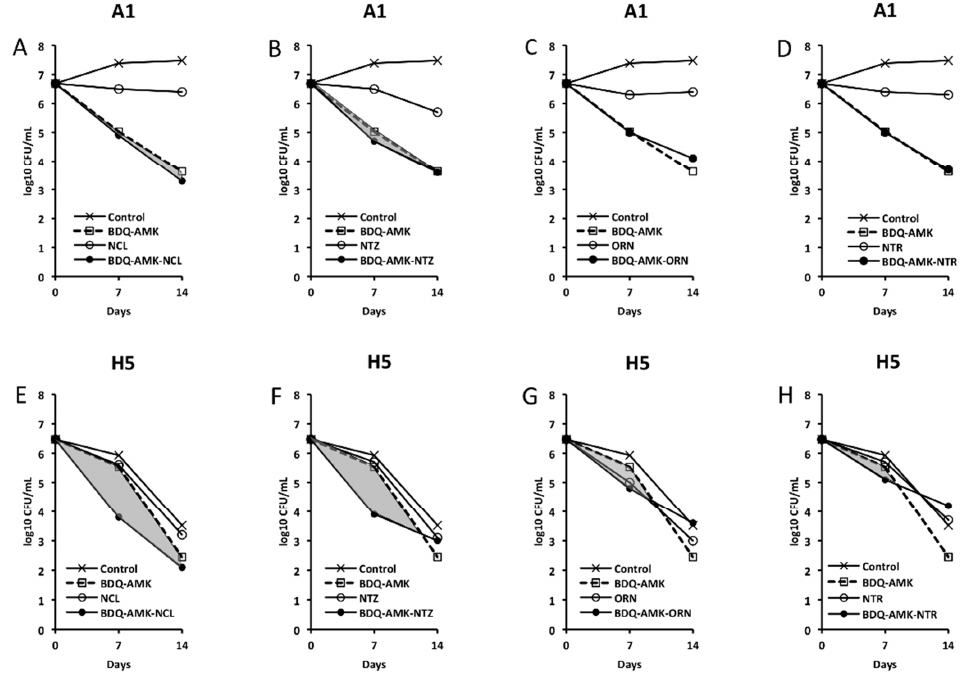
Figure 6. Activity against A1 and H5 cells of 3-drug combinations containing bedaquiline-amikacin (BDQ-AMK). ( A , E ) BDQ-AMK ± niclosamide (NCL); ( B , F ) BDQ-AMK ± nitazoxanide (NTZ); ( C , G ) BDQ-AMK ± ornidazole (ORN); ( D , H ) BDQ-AMK ± nitroxoline (NTR). Increases in the activities of (BDQ-AMK + third drug) versus BDQ-AMK are highlighted in grey.